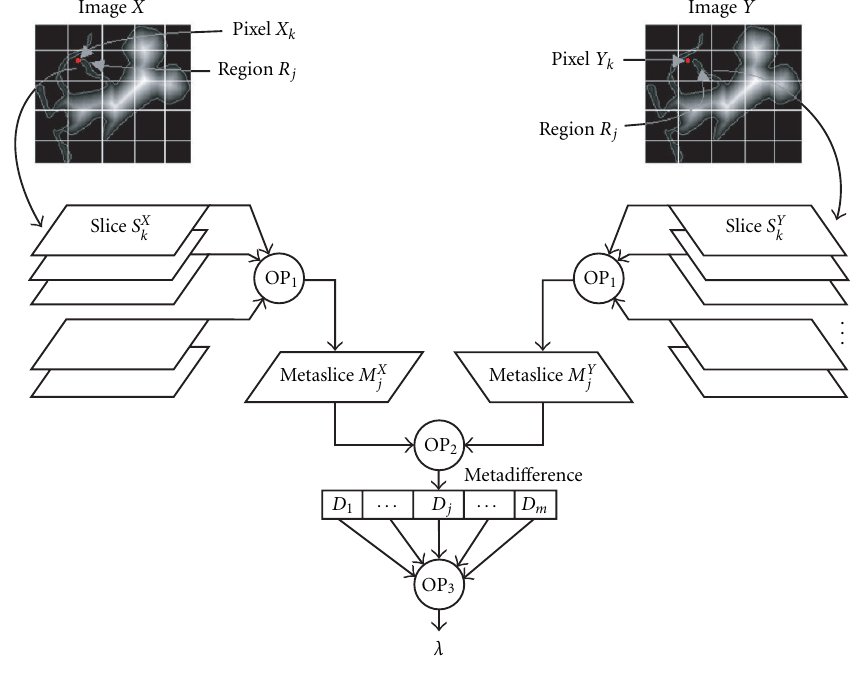
Figure 5: The general framework for ordinal correlation of images.